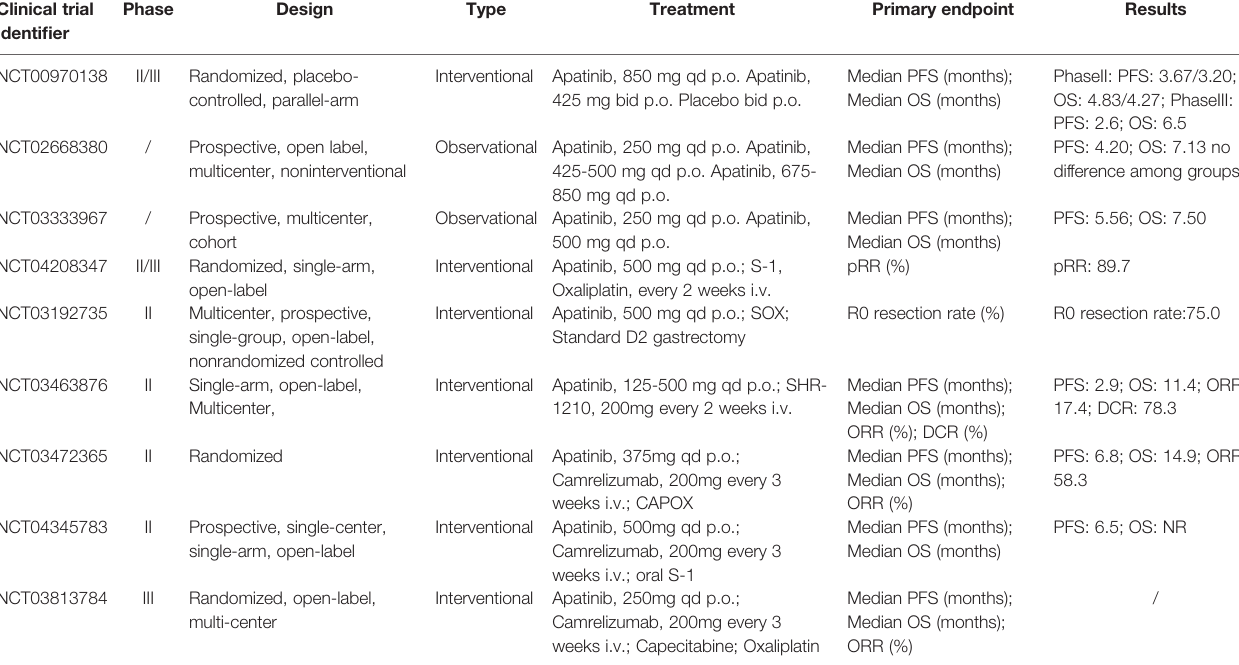
TABLE 1 | Selected clinical trials with apatinib in advanced gastric cancer. Clinical trial identi fi